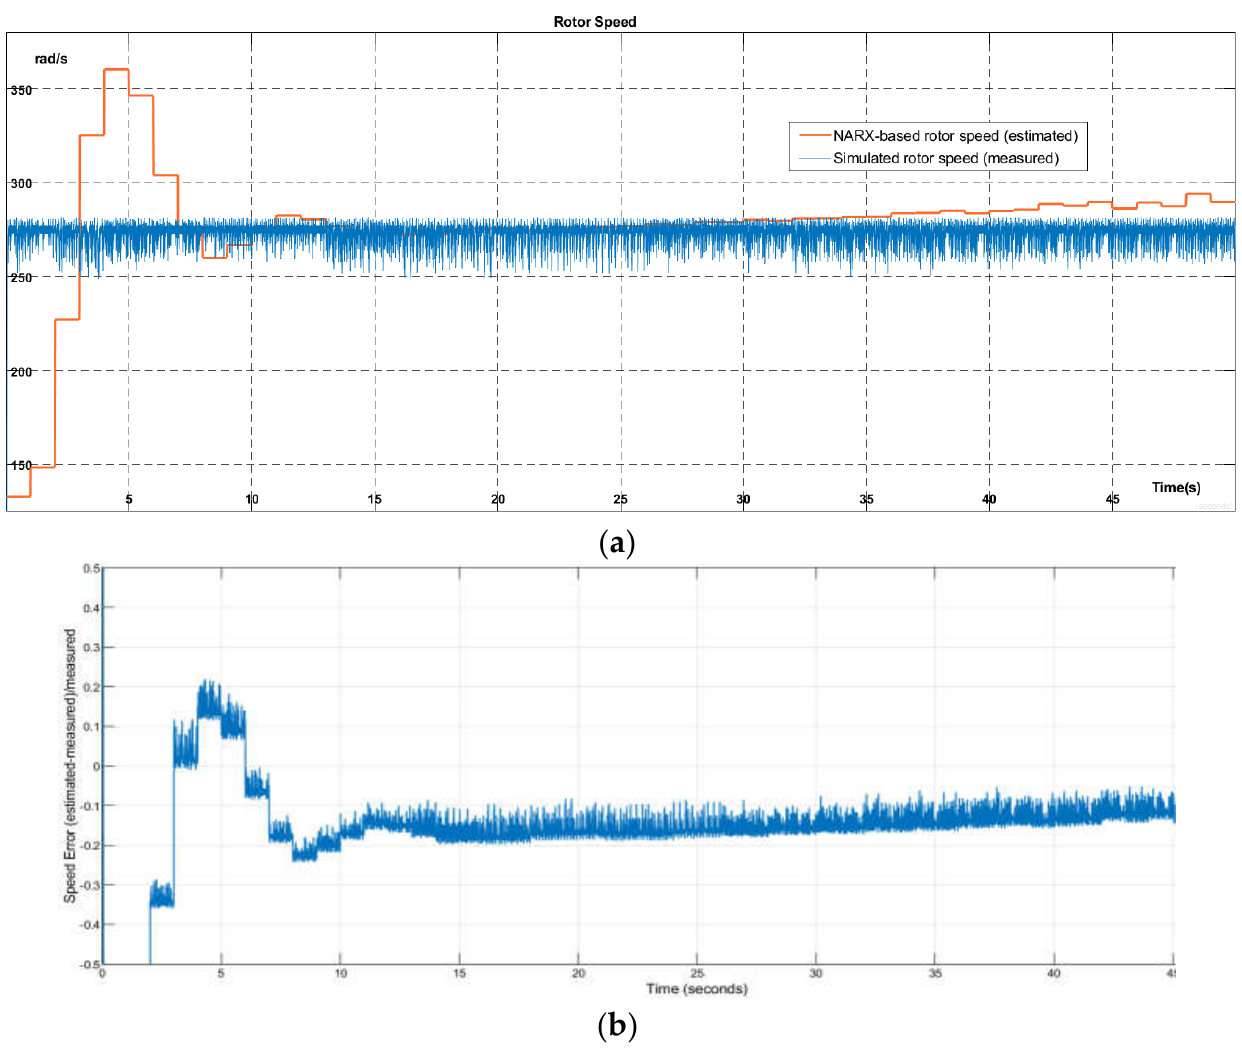
Figure 19. ( a ) Rotor speed ω r measured (orange) using the IM drive Simulink model, estimated (blue) by the generated block from ‘narx_net’; ( b ) Rotor speed error between measured and estimated ω r (scaled to 1.0).